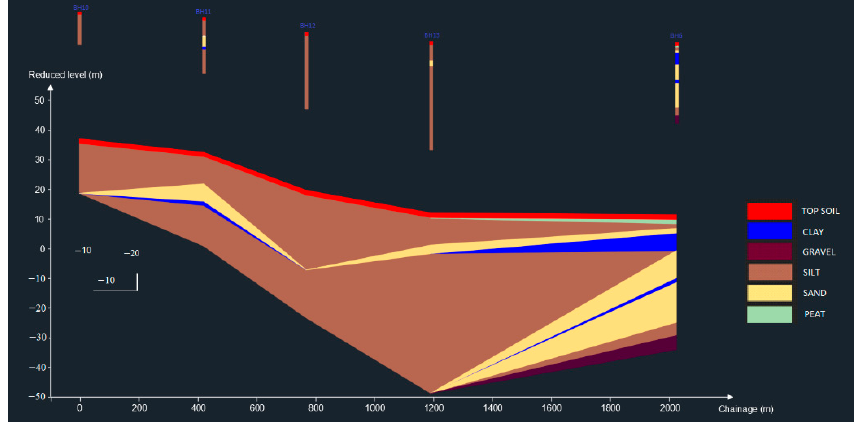
Figure 8. Cross-sectional profile for Case Study 2 based on generalized soil profile.